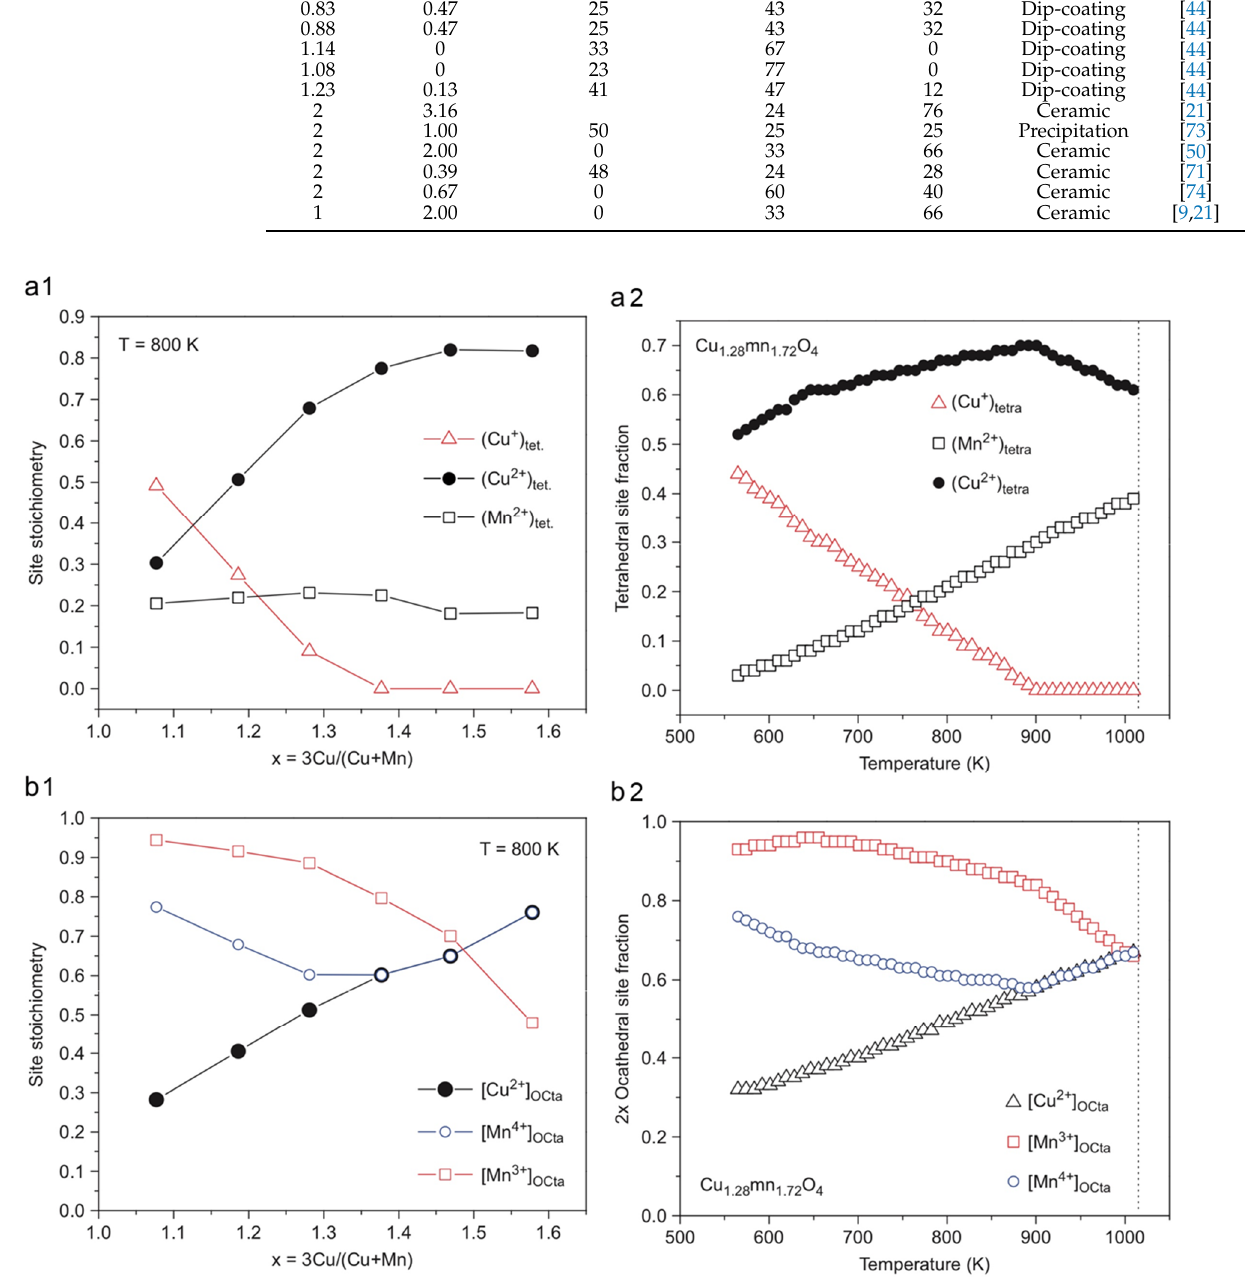
Figure 3. Variation of the cation valence and distribution on tetrahedral and octahedral sites with temperature and composition for Cu 1.28 Mn 1.72 O 4 . The vertical dashed line corresponds to the onset of CuO precipitation (reproduced from